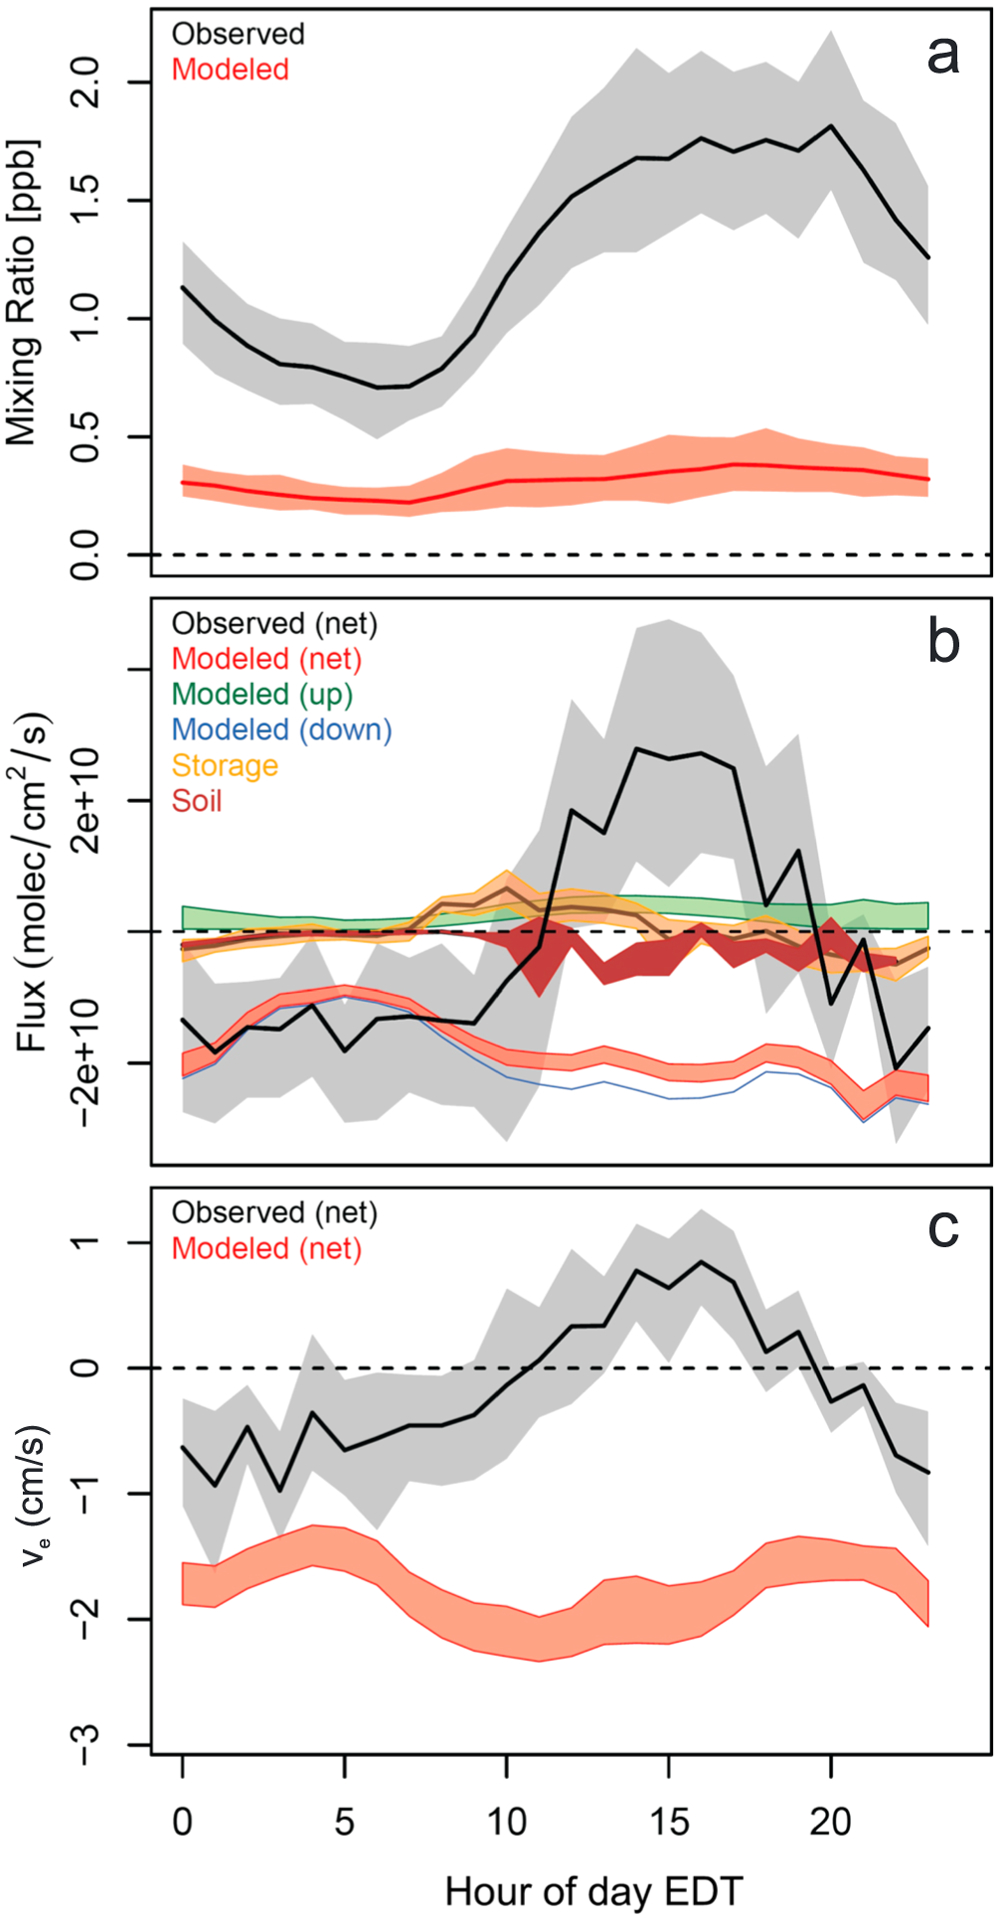
Mean diel profiles of HCOOH (a) mixing ratios, (b) fluxes, and (c) exchange velocities as measured during PROPHET-AMOS and simulated by GEOS-Chem. The solid black lines and shaded gray regions show the observed mean and associated 95% confidence interval, with the corresponding model values shown in red. Shaded regions for the model fluxes and exchange velocities span upper and lower limits for in-canopy production and loss as described in supporting information S1. Along with the measured above-canopy flux, (b) shows the observed contributions from canopy storage (orange) and soils (brown; the shaded region here spans the range from the three chambers with exposed soil after correcting for wall effects based on the blank chamber). Also shown in (b) are the model-derived gross upward (green) and downward (blue) fluxes.